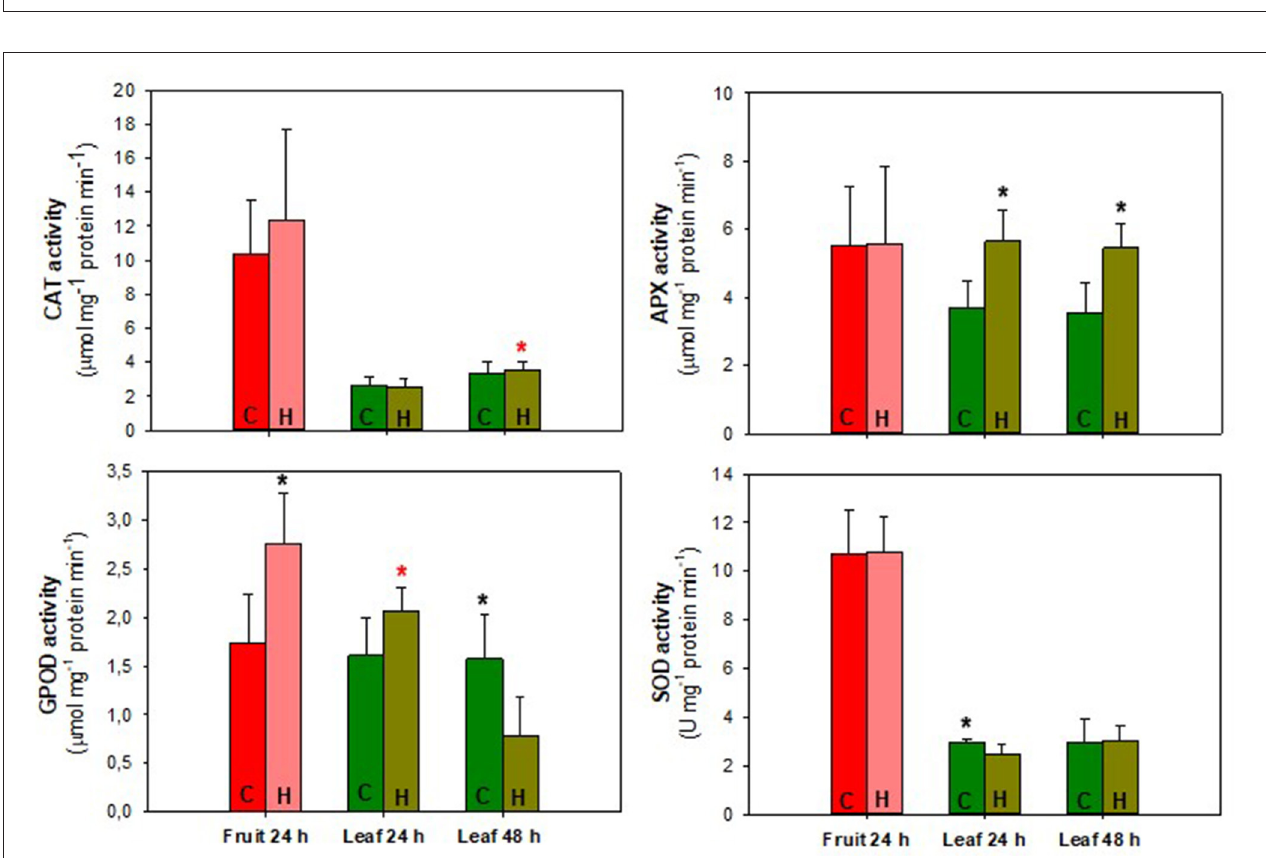
FIGURE 7 | Hydrogen peroxide and superoxide anion content of “Micro-Tom” tomato fruit and leaves during 24/48h of herbivory treatment ( H. armigera ). Values represent the mean ± SD ( n = 5). Black * represents statistical difference between control and herbivory 24h or control and herbivory 48h. Red * represents statistical difference between control 24 and 48h or herbivory 24 and 48h. C, control treatment; H, herbivory treatment.